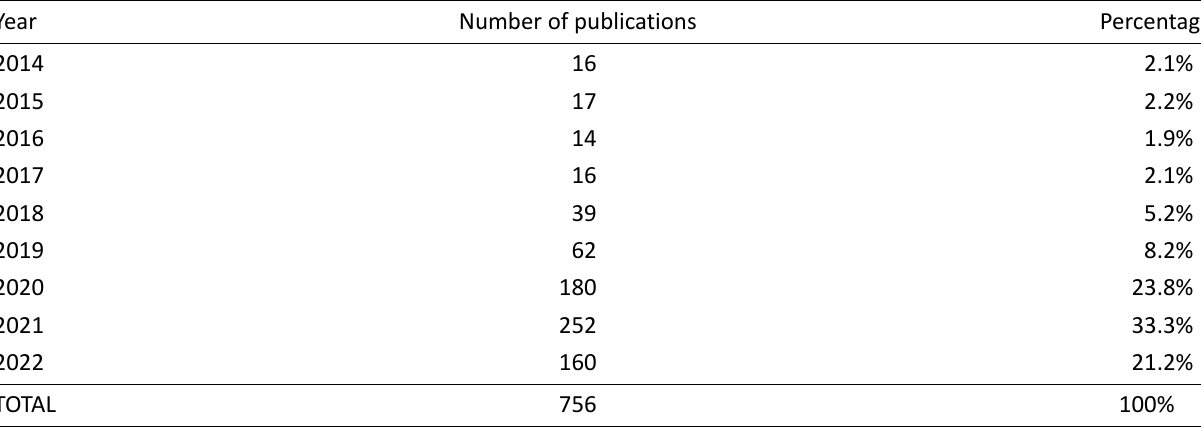
Table 1. Number of publications over